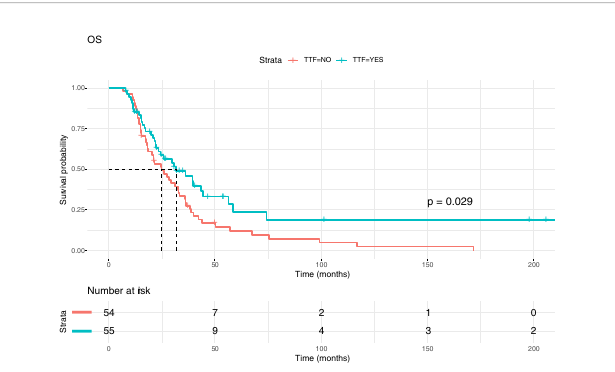
FIGURE 5 Kaplan-Meier curves showing progression-free survival (PFS) in GBM patients with and without TTFields